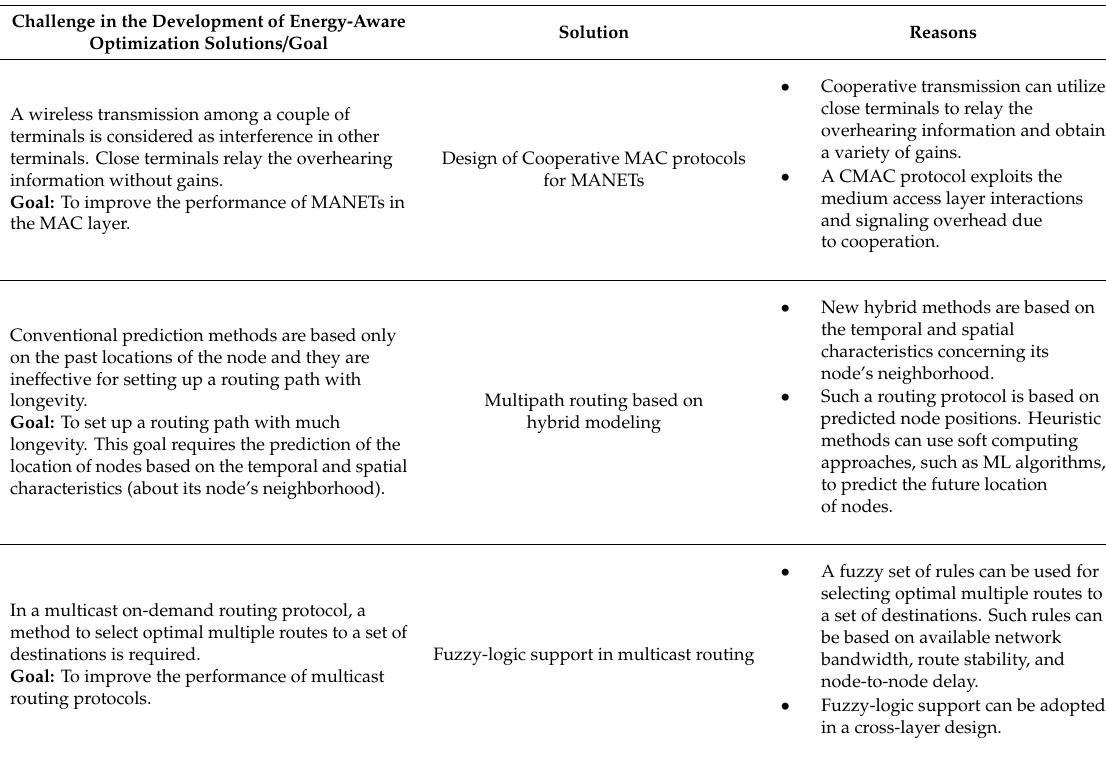
Table 6. Challenges in the development of energy-e ffi cient optimization solutions for MANETs and their